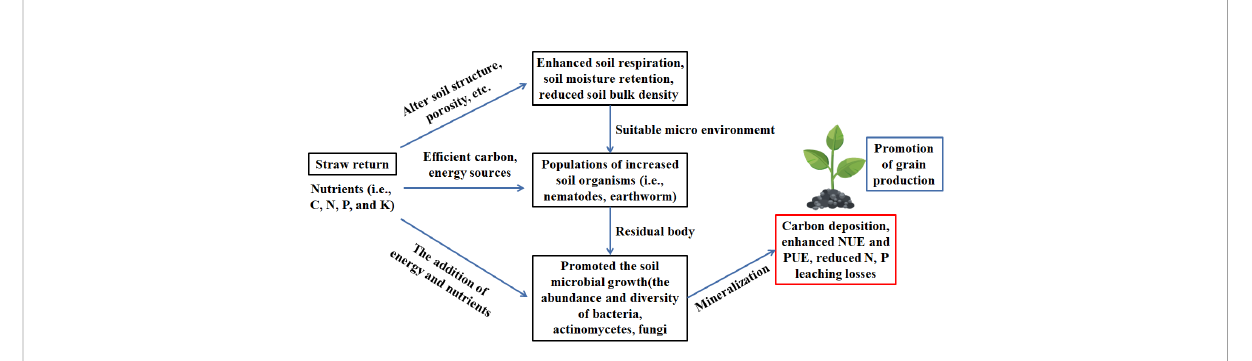
FIGURE 2 Straw return impact in soil for crop growth.